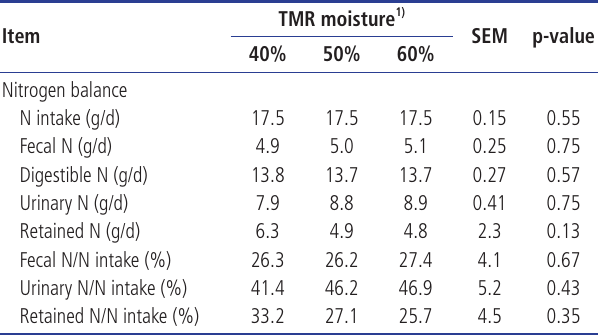
Table 3. Effects of adding water to TMR on nitrogen balance in ewes during hot and humid conditions Item